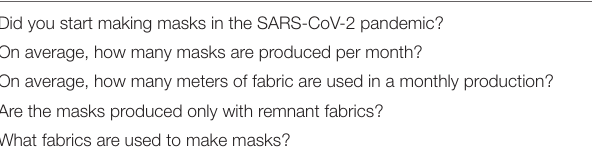
TABLE 1 | Questionnaire applied to the professional